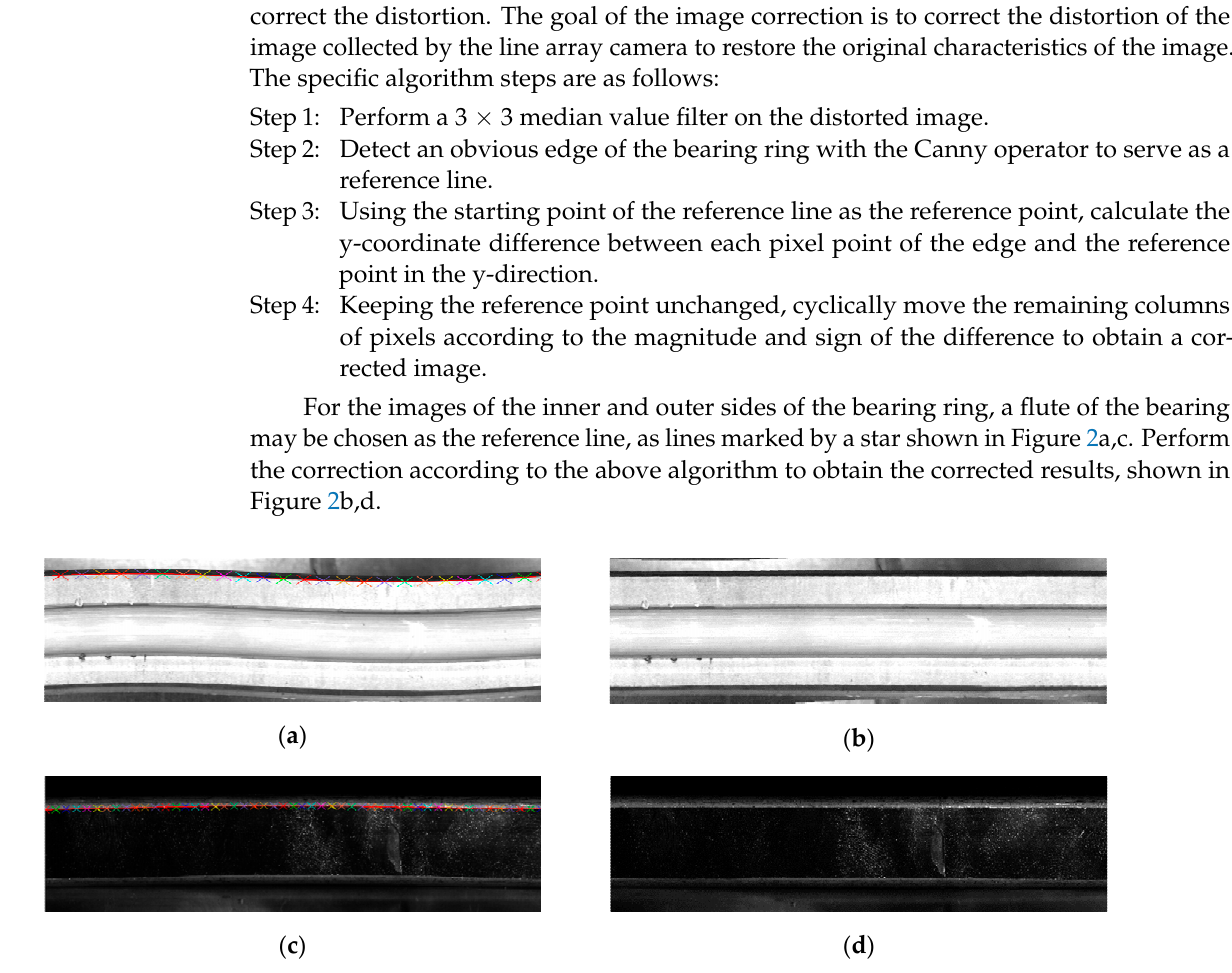
Figure 2. Comparison of side images before and after correction: ( a ) inner side image before correction; ( b ) inner side image after correction; ( c ) outer side image before correction; ( d ) outer side image after correction.